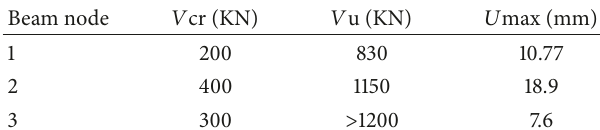
Table 4: Summary of shear resistance of beams.